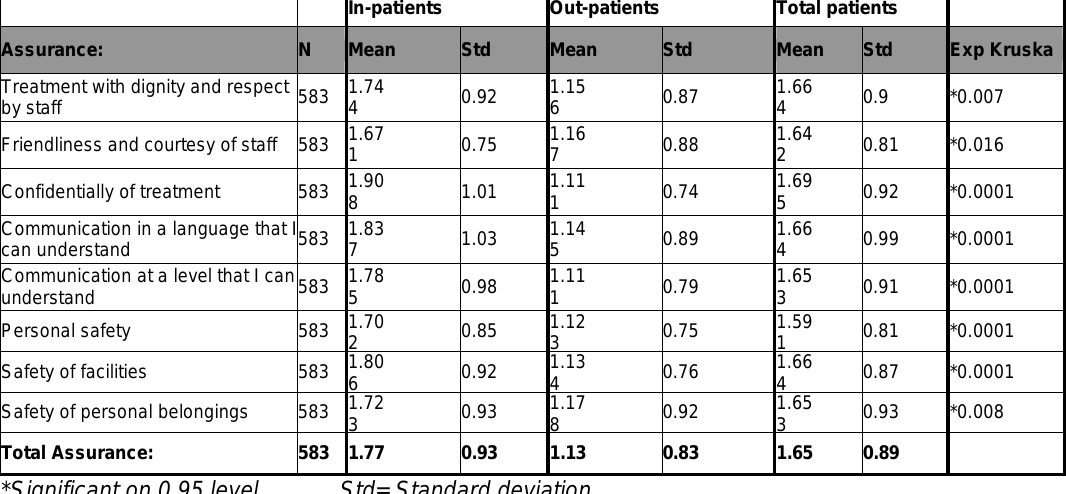
Table 3: Test for differences with regards to expectations on assurance constructs In-patients Out-patients Total